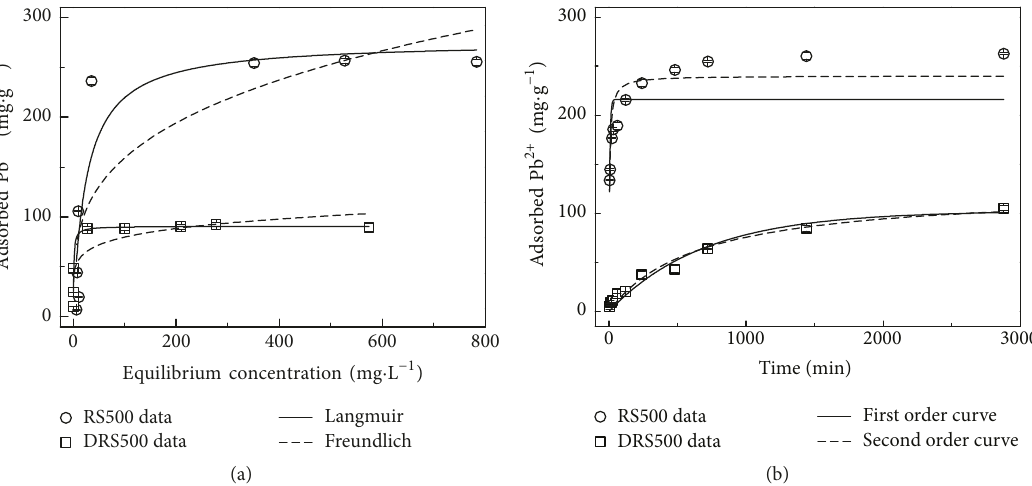
Figure 4: Adsorption isotherms and kinetics of Pb(II) adsorption on biochars: (a) adsorption isotherms of RS-500 and DRS-500; (b) adsorption kinetics of RS-500 and